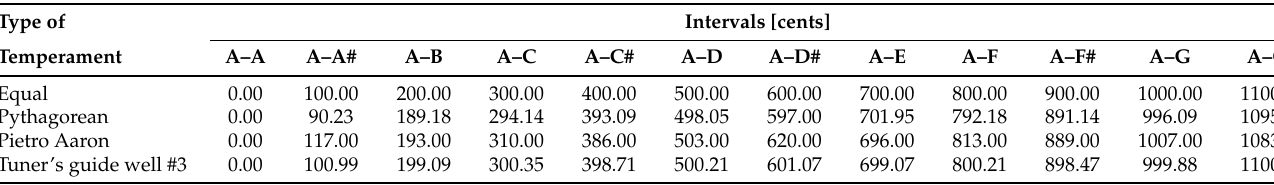
Table 2. Examples of